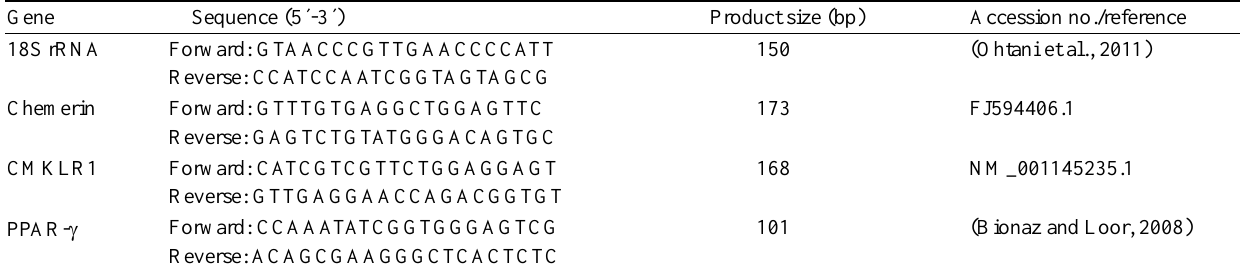
Table 1. The sequences of primers used in this